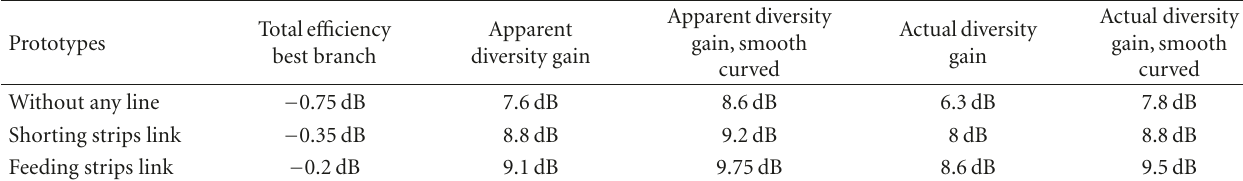
Table 3: Summary of the measured and computed diversity gains of all the antenna systems.